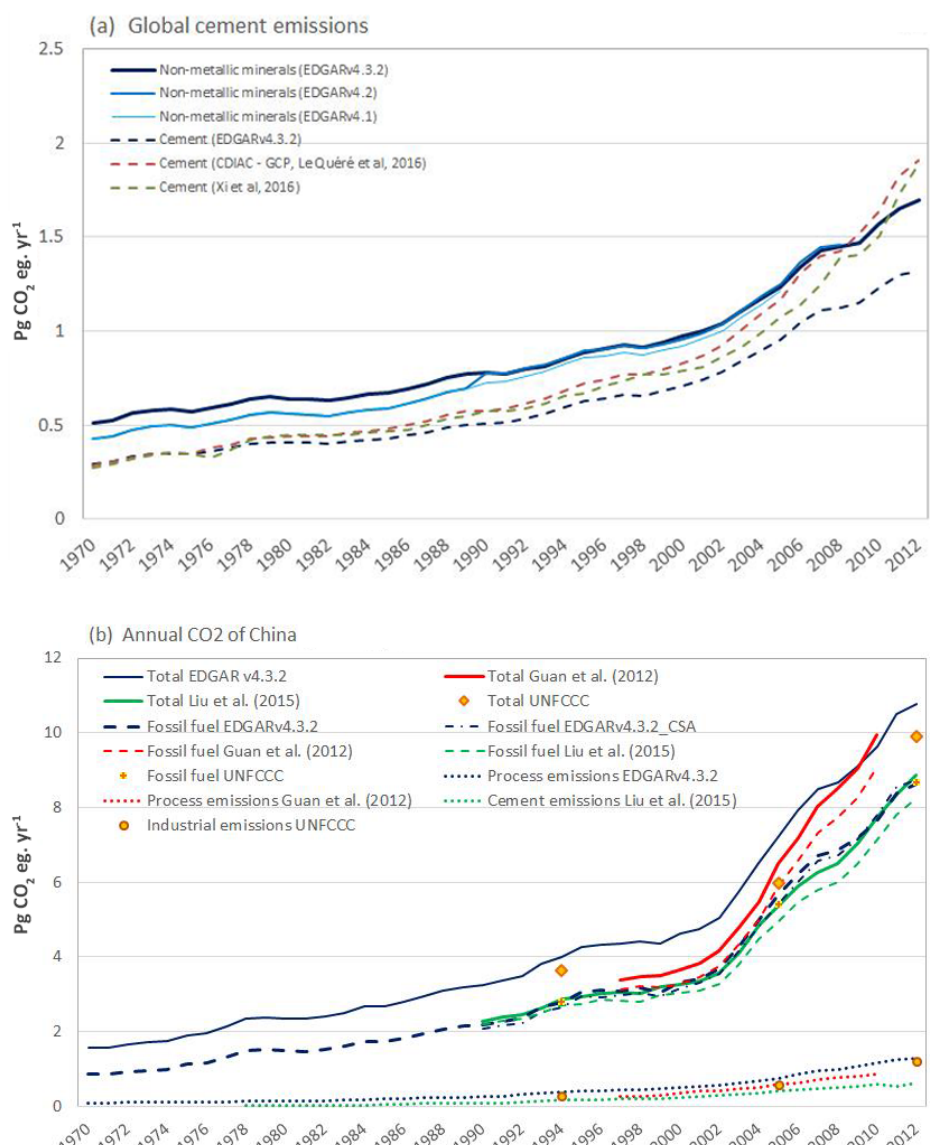
Figure 6. Intercomparison of CO 2 emissions trends estimated by EDGAR and by others with (a) details for cement process emissions globally with data of Le Quéré et al. (2016) and Xi et al. (2016), and (b) details for China’s sector-specific emissions with data of Guan et al. (2012) and Liu et al. (2015). The total is for all datasets subdivided into fossil fuel combustion and industrial process emissions (i.e. non-combustion industrial emissions, including